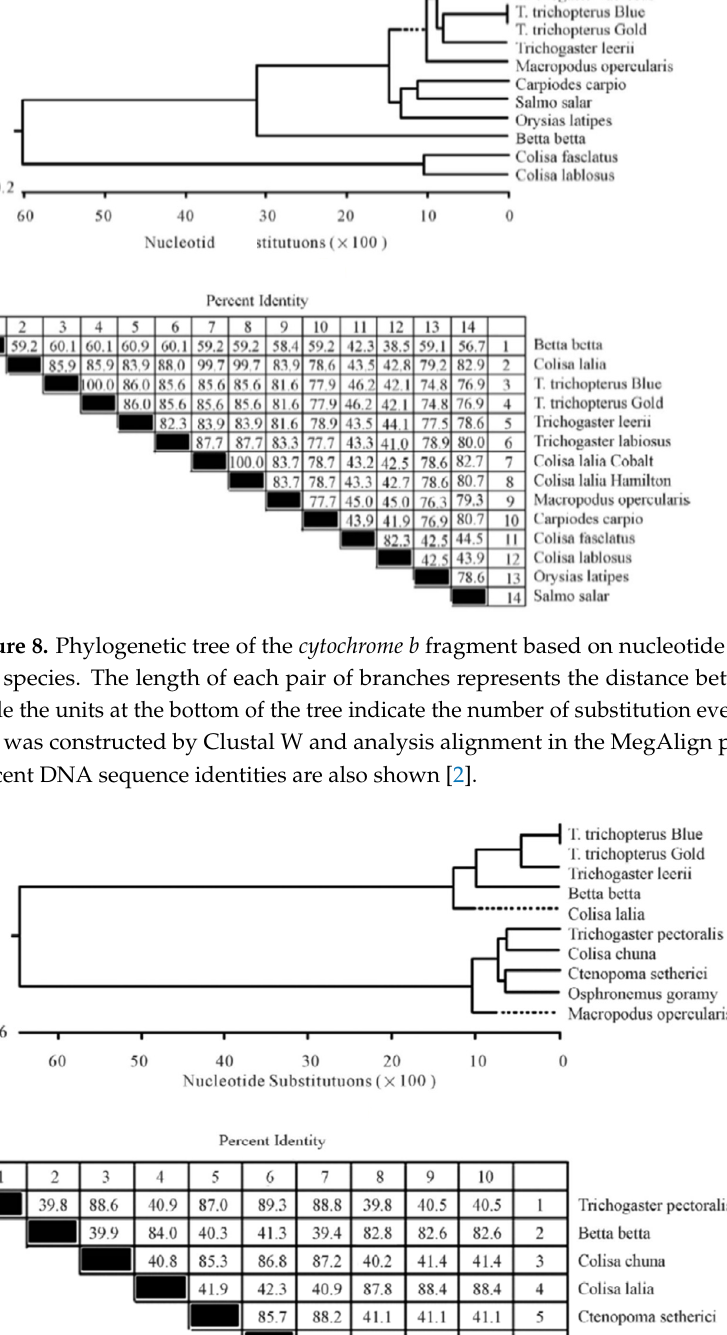
6 of 23 Figure 7. Phylogenetic tree constructed from analysis of 12S rRNA gene sequences of T . trichop- terus (blue gourami and gold gourami), T. leerii (pearl gourami), C. lalia (dwarf gourami), and B. betta (fighting fish). The phylogenetic tree was constructed by ClustalW and analysis align- ment methods in the MegAlign program (DNASTAR). Branch lengths represent evolutionary